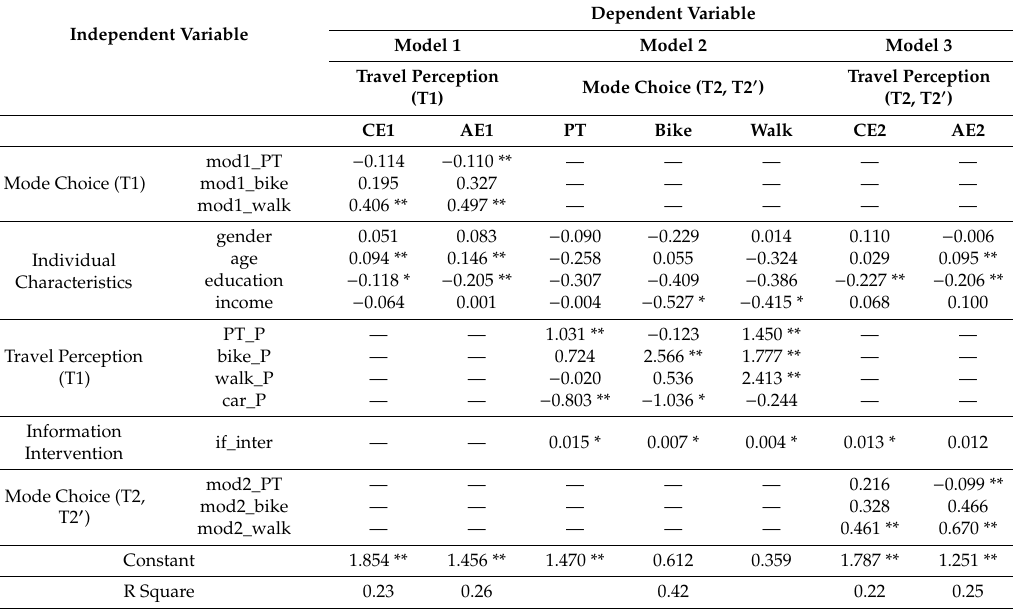
Table 7. Regression results of information intervention process model (N =